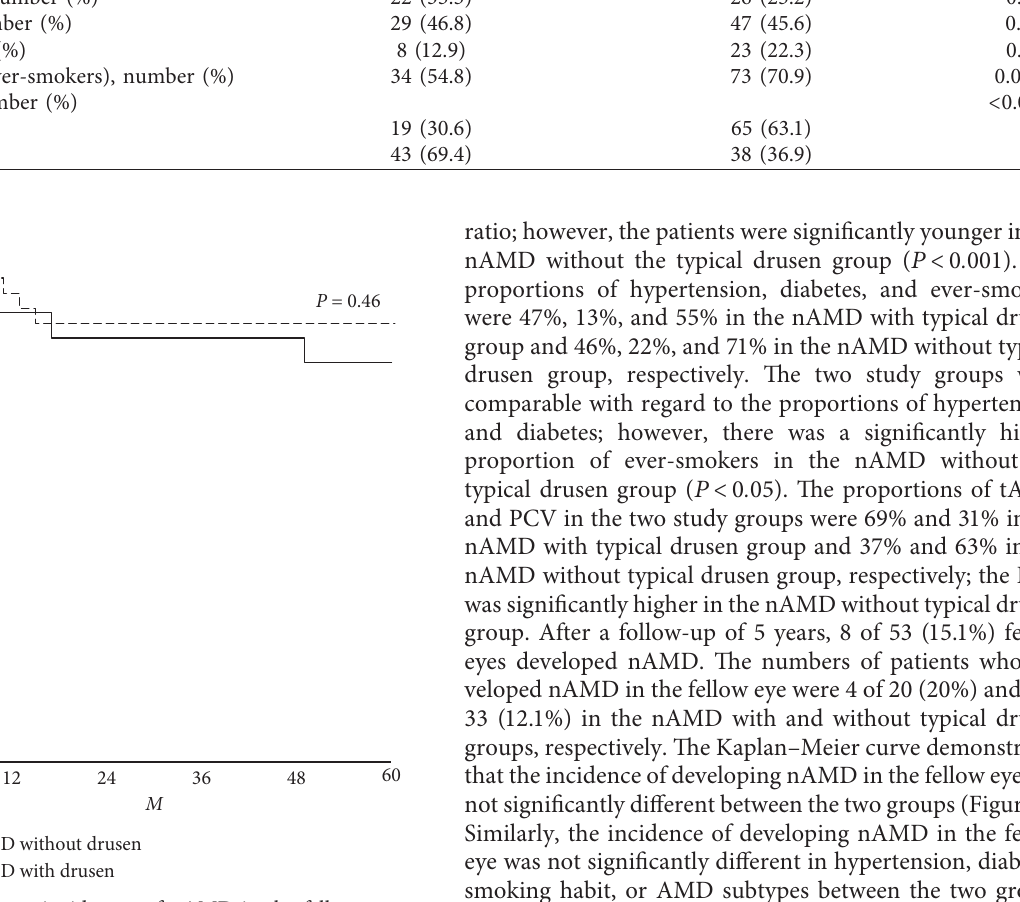
Figure 2: The 5-year incidences of nAMD in the fellow